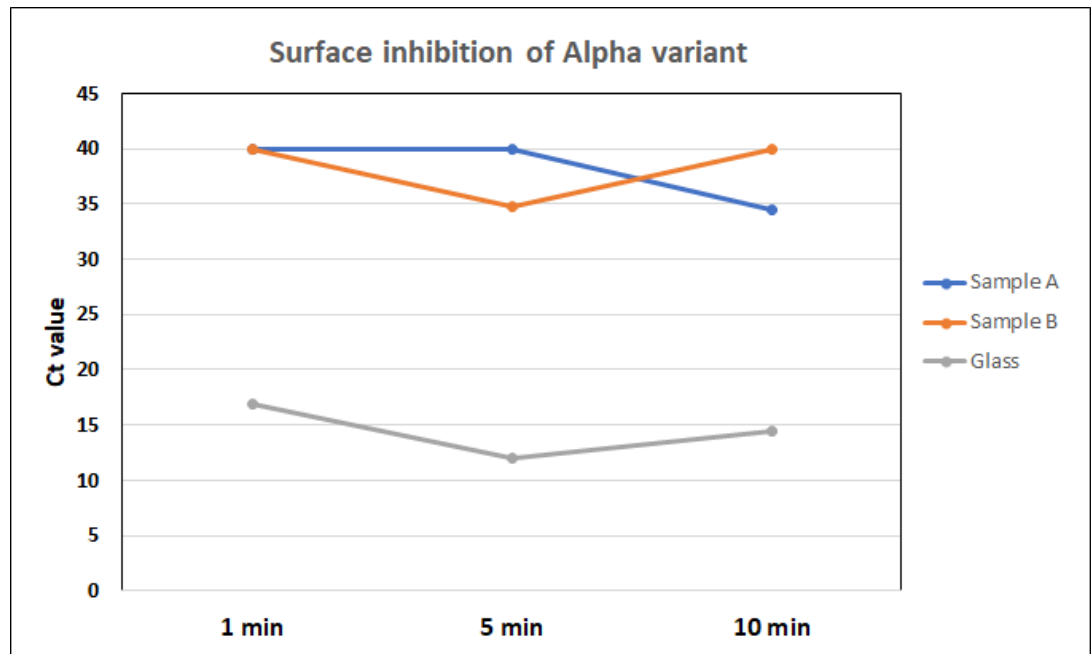
Figure 7. Ct values of the RT-PCR that were performed from post-culture media of separate wells. Ct values were set to 40 for samples with no Ct values.